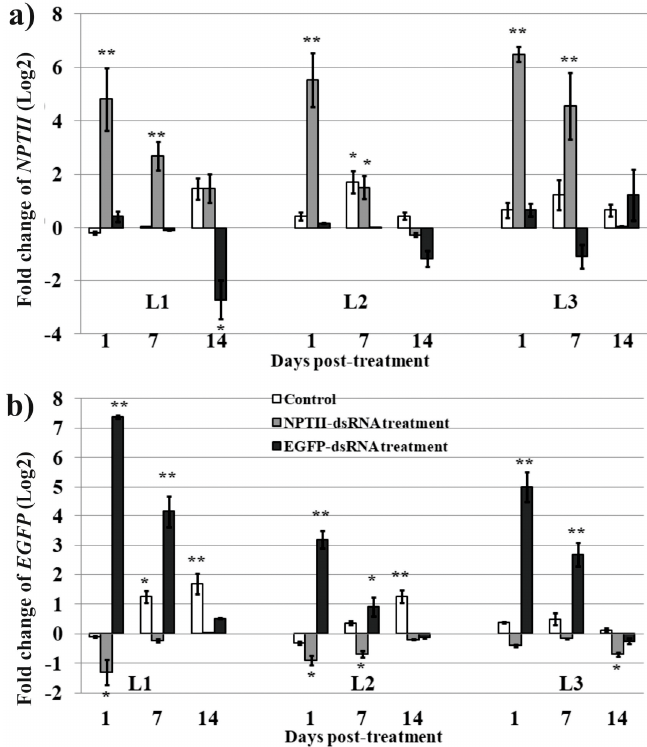
Figure 3. The analysis of NPTII ( a ) and EGFP ( b ) transgene transcript levels (log2 fold change) using primers designed to align inside the NPTII and EGFP transgene fragments, which have been used for synthesis of the corresponding dsRNAs, in the dsRNA-treated four-week-old Arabidopsis thaliana relative to that in the plants before treatments. One plant of the L1, L2, and L3 lines for each treatment was treated with NPTII -dsRNA, EGFP -dsRNAs or filtered sterile water (Control). The dsRNA were diluted in water to 0.35 µ g/ µ L (100 µ L per plant). In an experiment, the RNA was isolated before, 1, 7, and 14 days post-treatment from each plant (three independent experiments). qRT-PCR data are presented as mean ± SE. *, **—significantly different from the plants before treatment at P ≤ 0.05 and 0.01, respectively, according to the Student’s t